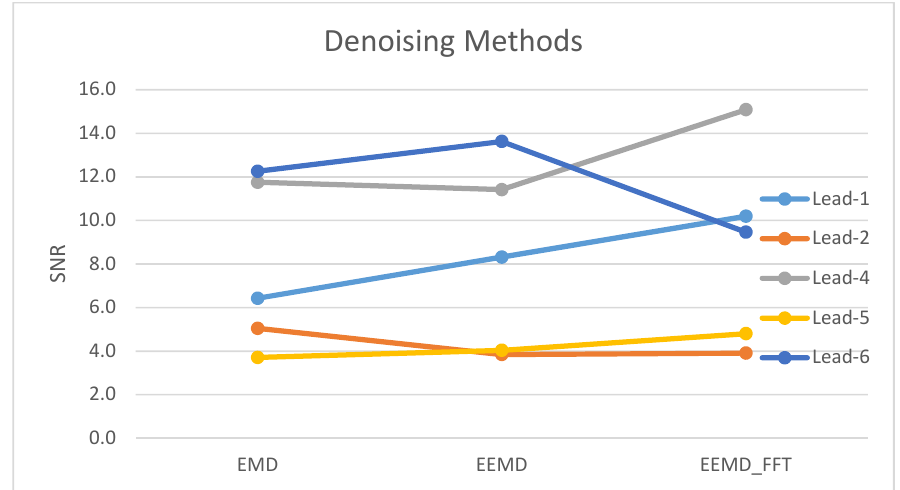
Figure 10. Denoising methods comparison plot among data ‐ driven denoising methods—EMD, EEMD (ensemble empirical mode decomposition) and EEMD ‐ fft—applied to the arm ‐ ECG bipolar lead set study (Golden cases, N = 18).